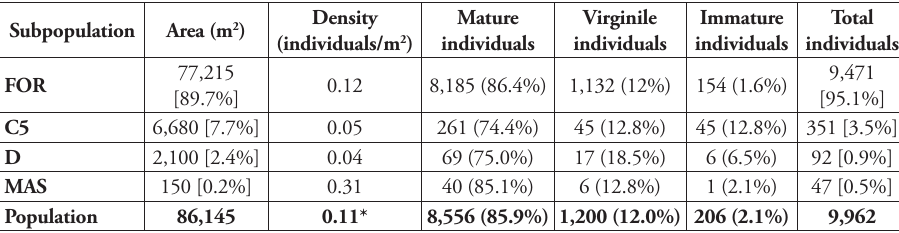
Table 1. Demographic structure of the Italian population of C. laurifolus subsp. laurifolius . In square brackets: % values of area of occupancy and individuals with respect to the whole population. In round brackets: % age-stage classes with respect to the whole number of individuals for each sub-population. * = mean